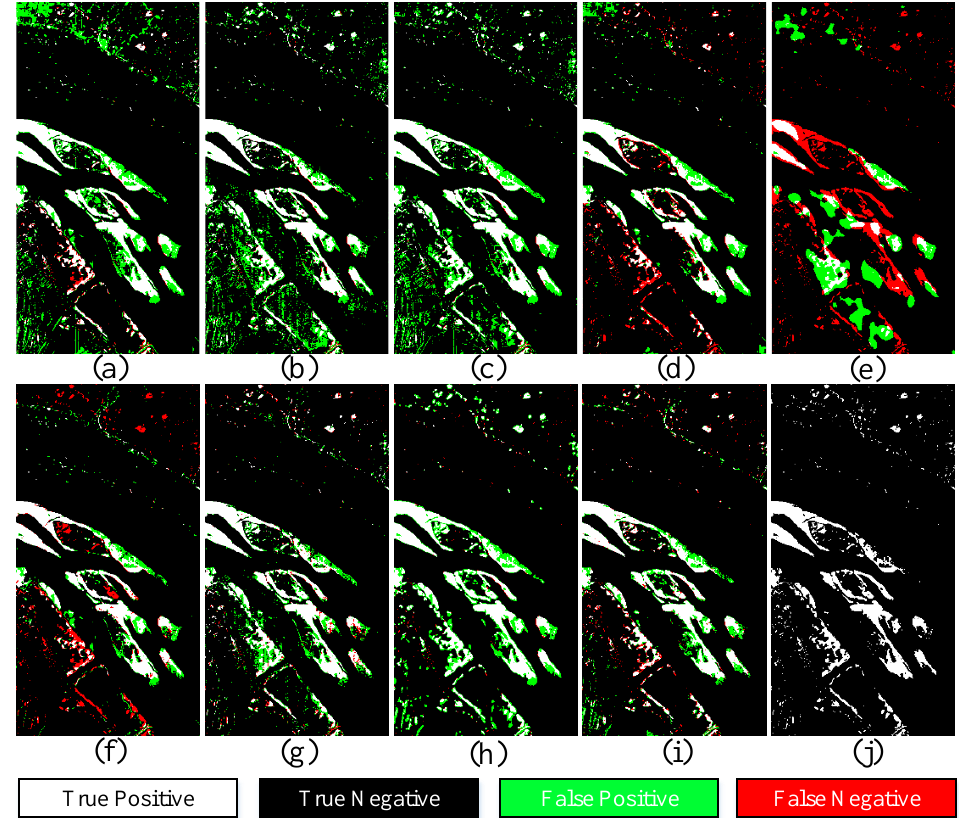
Figure 10. The visual results of different methods on the River dataset: ( a ) CVA [61], ( b ) KNN, ( c ) SVM, ( d ) RCVA [39], ( e ) DCVA [50], ( f ) DSFA [51], ( g ) GETNET [6], ( h ) TDSSC [20], ( i ) our ASSCDN, and ( j ) Reference